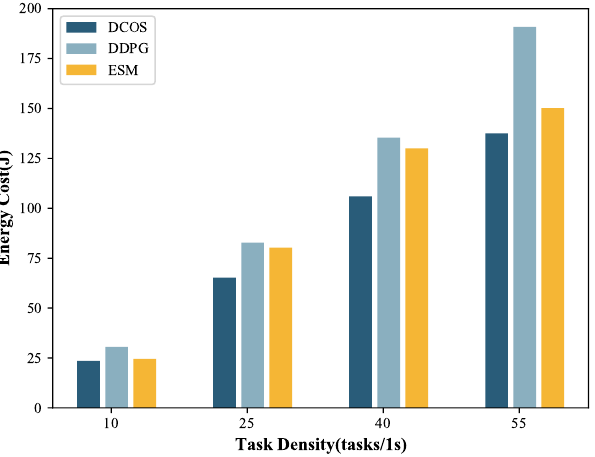
Figure 5. Energy consumption comparison for different task densities.